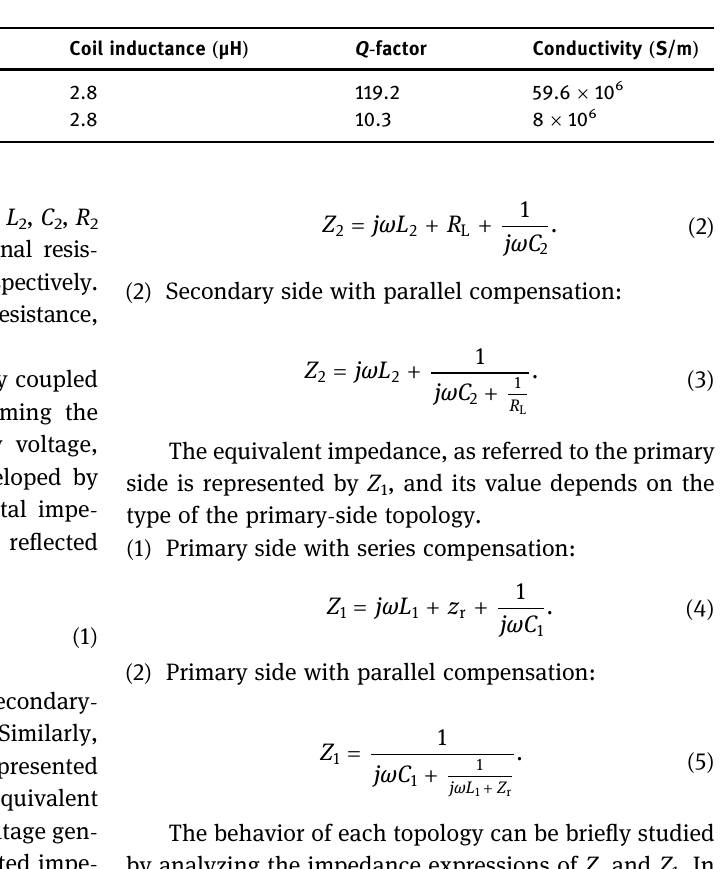
Here, Z , Z , and Z are the primary - side, secondary - 1 2 r side and re fl ected impedances, respectively. Similarly,